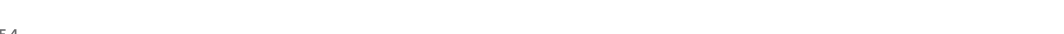
FIGURE4 images of immunofluorescence double staining (E) and quantitative analysis (F) of the cross-sections of adductor muscles 7 days after the surgery. Red, Ki67. Green, α -SMA. Blue, DAPI. (G,H) Representative images (G) and quantitative analysis (H) of HE staining and immunohistochemistry of α -SMA in cross-sections of the adductor muscles from AAV9-control + Exe- and AAV9-sponge-miR-125a-5p + Exe treated rats 7 days after surgery. (I-K) Representative images (I) and quantitative analysis (J,K) of immunofluorescence double staining and CD31 immunohistochemistry in cross-sections of the gastrocnemius muscles from AAV9-control + Exe- and AAV9-sponge-miR-125a-5p + Exe- treated rats 7 days after surgery. The ratio of Ki67-positive cells to the total ECs in each field was quantified. Red, Ki67. Green, CD31. Blue, DAPI. Arrows, representative Ki67 positive SMCs. N = 6 per group. * P < 0.05, ** P < 0.01, *** P < 0.001. AAV9-control + Exe vs. AAV9-sponge-miR-125a-5p + Exe. FAL indicates femoral artery ligation. Scale bar = 20 or 50 µ m, as presented in the above images. Data are means ±